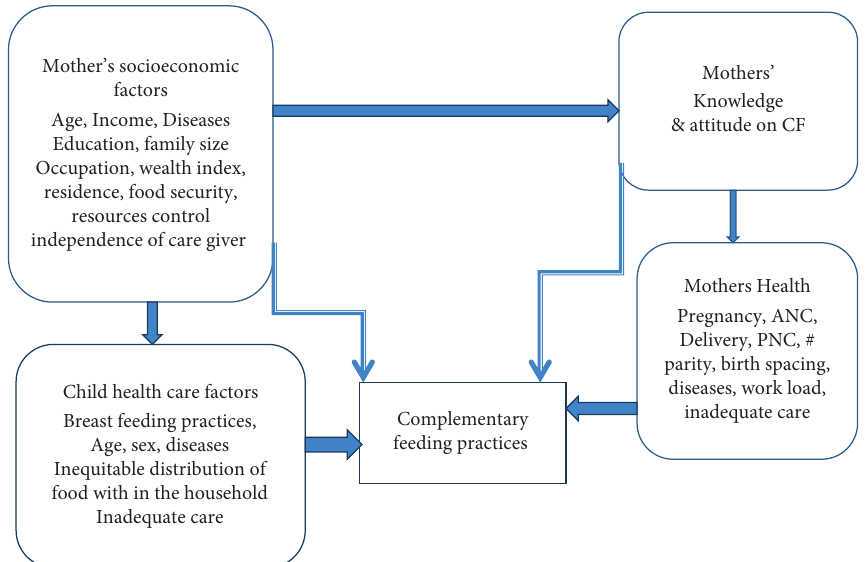
Figure 1: Conceptual framework of complementary feeding practice from the different literature review, 2020. CFP: complementary feeding practices, PNC: postnatal care, and ANC: antenatal